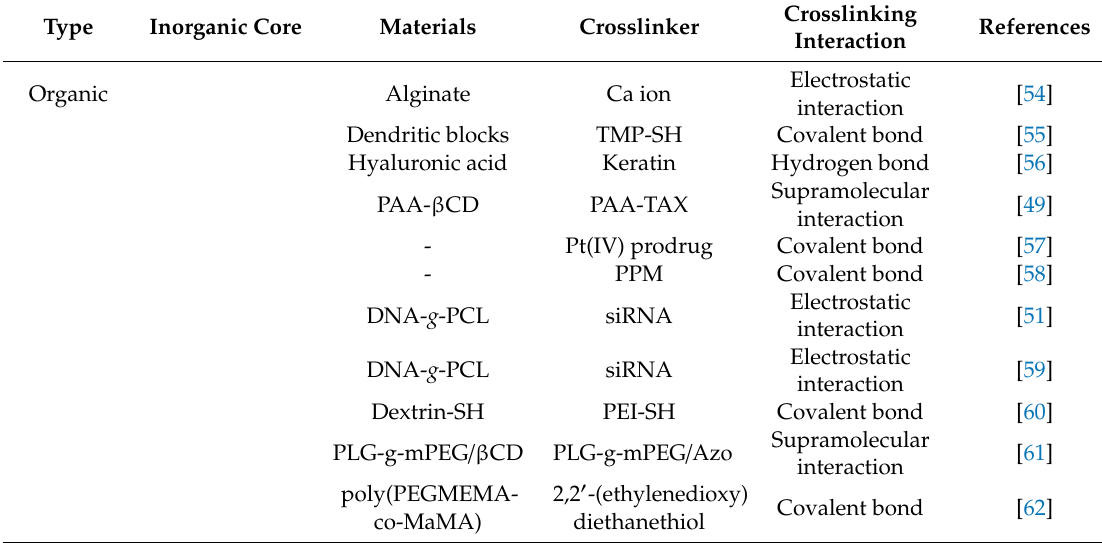
Table 1. Summary of the preparation of nanogels by types, inorganic cores, materials, crosslinkers and crosslinking interactions.